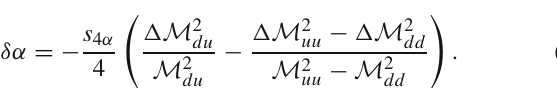
Fig. 1 Feynman diagrams for H → hh : a Tree-level diagram; b – f virtual one-loop corrections; g – j external self-energy corrections and countert- erm; k generic self-energy that comprises the self-energy corrections and the kinetic counterterm depicted in l – o level, which results